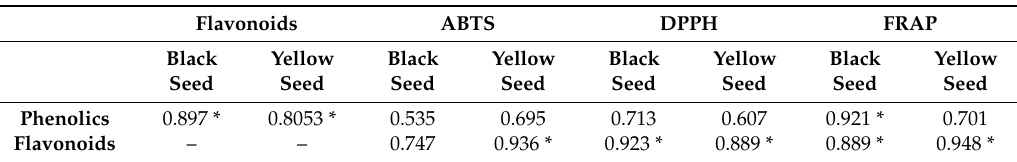
Table 2. Correlation coefficient analysis of phenolic compounds and antioxidant activity in developing seeds of yellow- and black-seeded B.